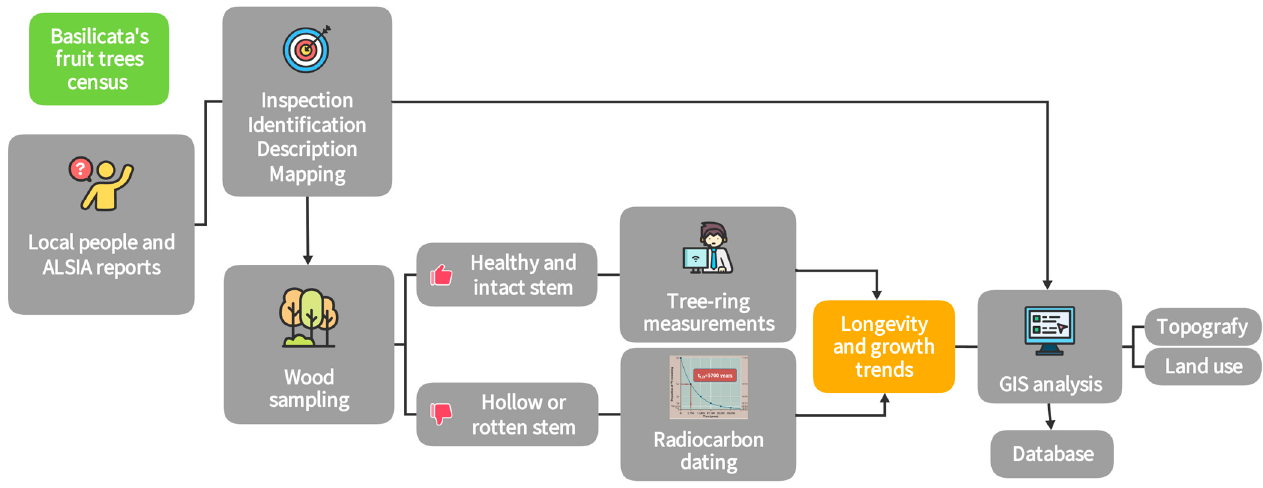
Figure 2. Flow chart describing the methods workflow. Reports from local people and ALSIA allowed for the inspection, identification, description, mapping, and wood sampling of old and mature fruit trees in Basilicata. Wood samples were tree-ring measured or radiocarbon dated based on stem morphology and wood condition. Longevity and growth trends assessed from tree ring and radiocarbon data were incorporated into the GIS environment to create an informative database and analyze topography and land use features. The flowchart was developed through the software GitMind, Ver. January 2023 (https://gitmind.com/, accessed on 10 February 2023).